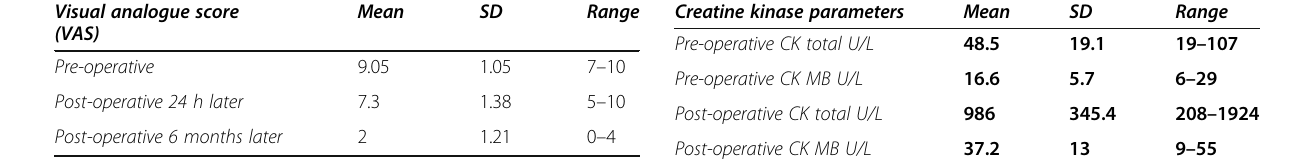
Table 3 Pre- and post-operative visual analog score values of the included patients in our study Visual analogue score Mean SD (VAS)